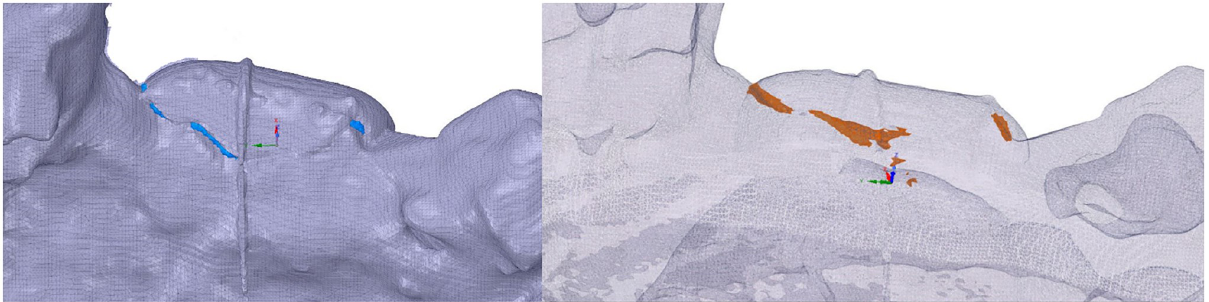
Fig 4. Representative virtual 3D model with graft. Blue and orange colored volume of the void between model and graft.